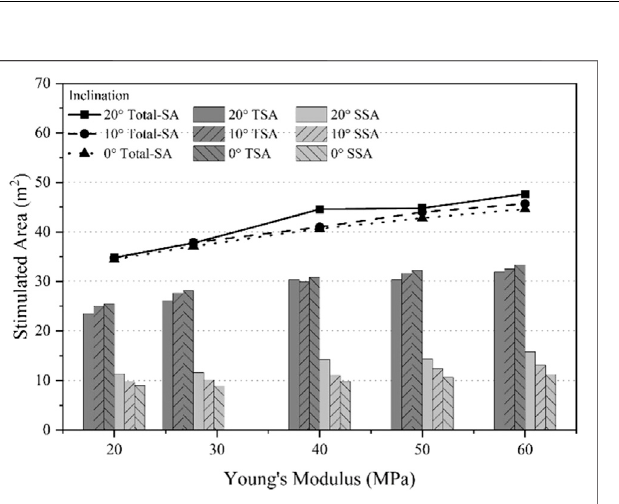
Frontiers in Earth Science |